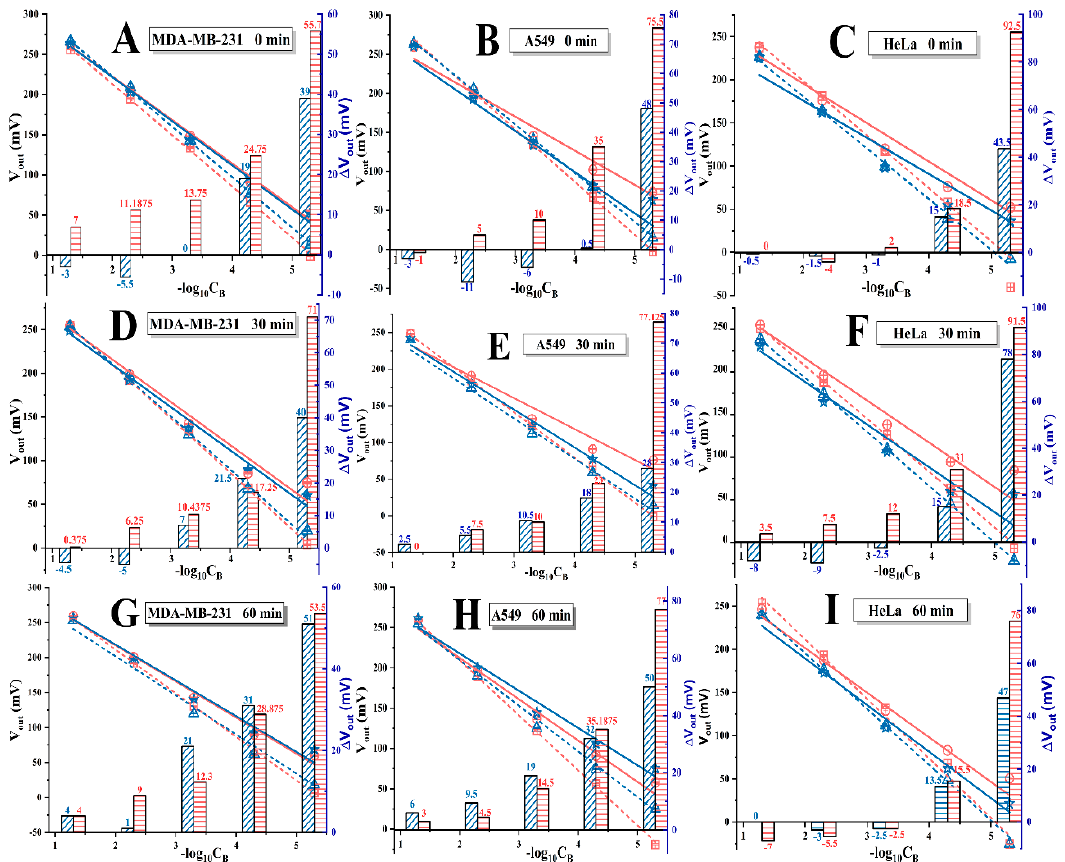
Figure 3. The ISEs responding curves for varied I - concentrations in the background solutions (KI/KNO 3 ), before and after they are immobilized by cells, in the tested group (TG) and control group (CG), which are treated by the iodide uptake (IU) operation with the durations of 0, 30, 60 min. The results are arranged in a matrix according to the cells’ type (MDAMB231, A549 or HeLa), and the duration of IU treatment. That is, the first row shows the results of ISEs on immobilized MDAMB231 ( A ), A549 ( B ) and HeLa ( C ) cells without IU treatment (NIU), respectively, the last two rows are the results of the similar ISEs with the only difference in the varied durations of IU treatment (D, E and F for 30 min, G, H and I for 60 min). In each of the figures, the histogram shows the changes of the voltage value ( Δ V out